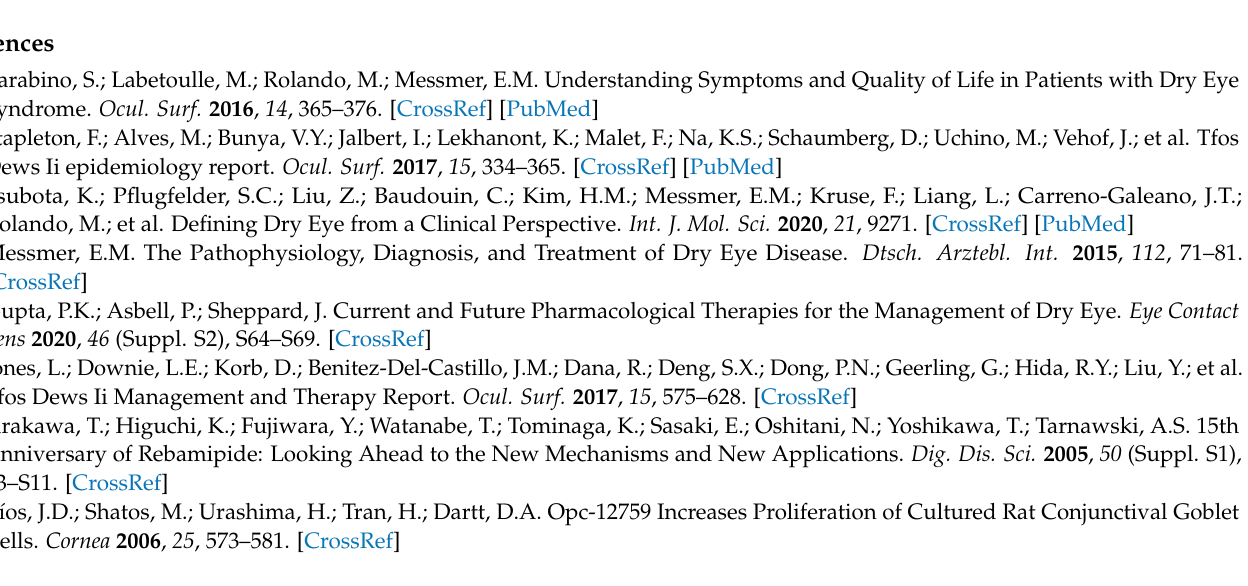
Table S2: Evaluation on dose linearity in the pharmacokinetic parameters of SA001 and rebamipide using the power model; Table S3: Summary of treatment emergent adverse events (TEAEs) by sys- temic organ class and preferred term after single oral administration of SA001; Table S4: Relationship between the plasma concentration of SA001 and rebamipide with the corrected QT interval using linear